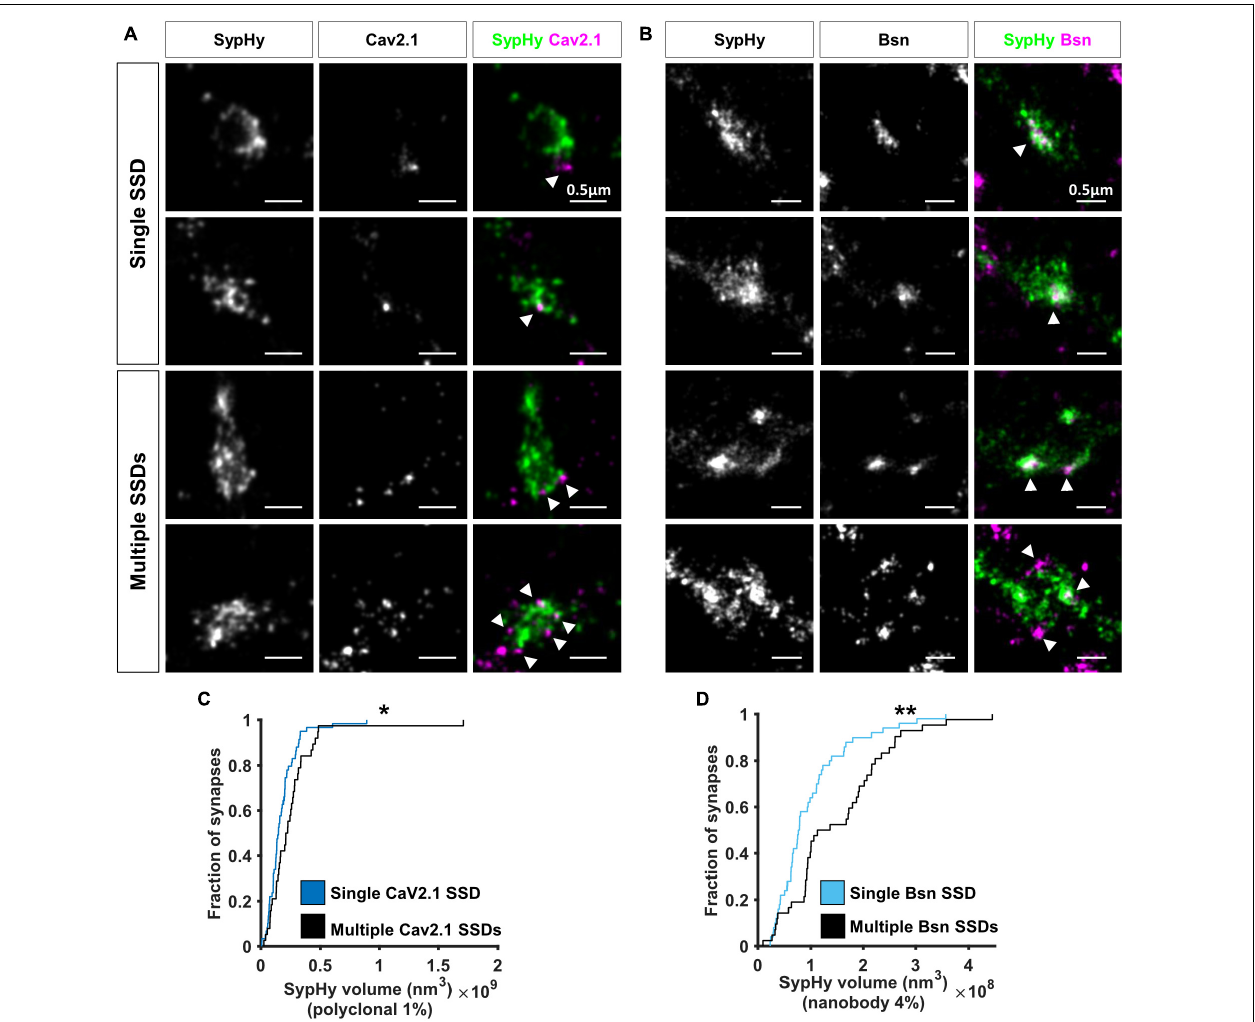
FIGURE 4 | Nanoscale organisation of Cav2.1 and Bassoon in SypHy-RGECO + ve boutons. (A,B) Examples of SypHy-RGECO + ve boutons labelled for SypHy-AF647 (left panels) and Cav2.1-CF680 (A: middle panels) or Bassoon-CF680 ( B , middle panels) imaged with SD-dSTORM. Merged images of SypHy (green) and Cav2.1 ( A , magenta) or Bassoon ( B , magenta) are shown in the right panels. White arrows indicate Cav2.1 or Bassoon subsynaptic domains (SSD). Synapses can contain a single (top panels) or multiple SSDs (lower panels). (C) Cumulative distribution of SypHy cluster volume labelled with polyclonal anti-GFP and AF647-coupled secondary antibodies after 1%PFA fixation, for synapses with single or multiple Cav2.1 SSDs (Kolmogorov-Smirnov test, p = 0.025, n single = 59, n multi = 38). (D) Cumulative distribution of SypHy cluster volume labelled with AF647-coupled anti-GFP nanobody after 4%PFA fixation, for synapses with single or multiple Bassoon SSDs (Kolmogorov-Smirnov test, p = 0.004, n single = 50, n multi = 42). * p < 0.05 and ** p <